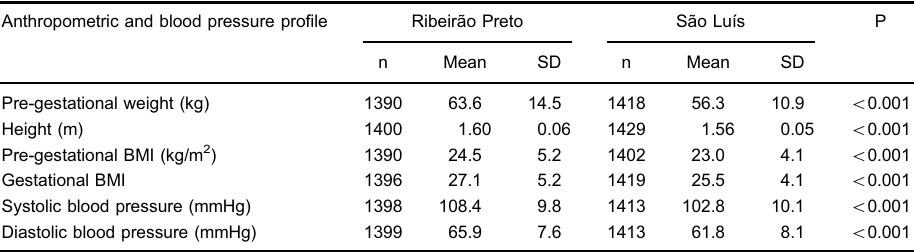
Table 3. Anthropometric and blood pressure pro fi les of pregnant women in Ribeirão Preto and São Luís 2010 birth cohorts. Anthropometric and blood pressure pro fi le Ribeirão